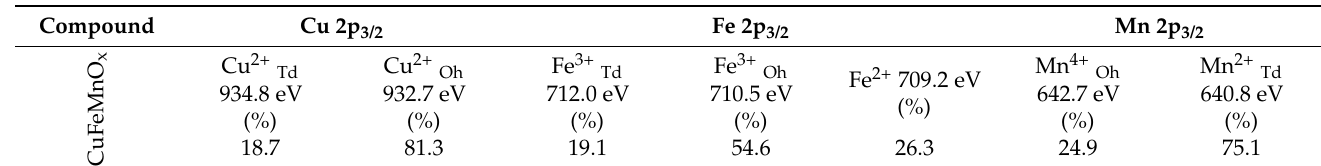
Table 2. Oxidation state and site distribution of iron, manganese and copper ions in FeMnCuO x thin film.